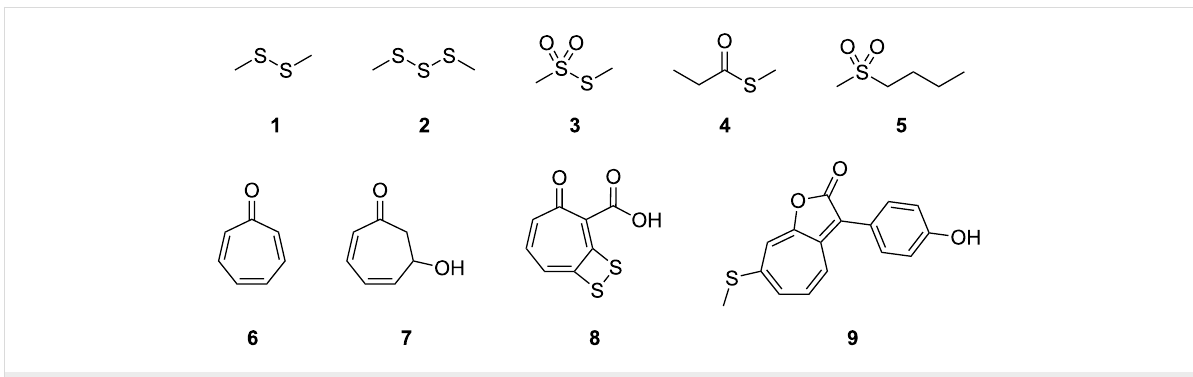
Figure 1: Roseobacter clade